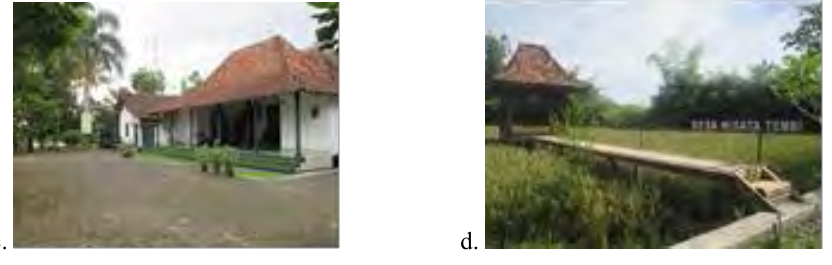
Figure 6(c) Tourist Attraction in Brayut (author, 2017) Figure 7(d) Tourist attraction in Tembi (author, 2017)